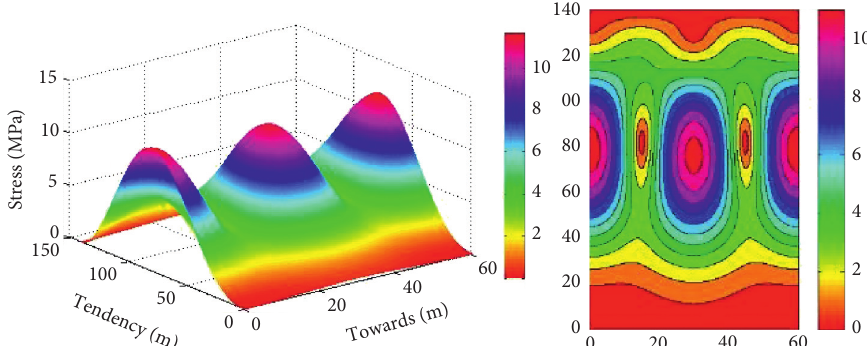
Figure 4: Neophogram of maximum shear stress of the main